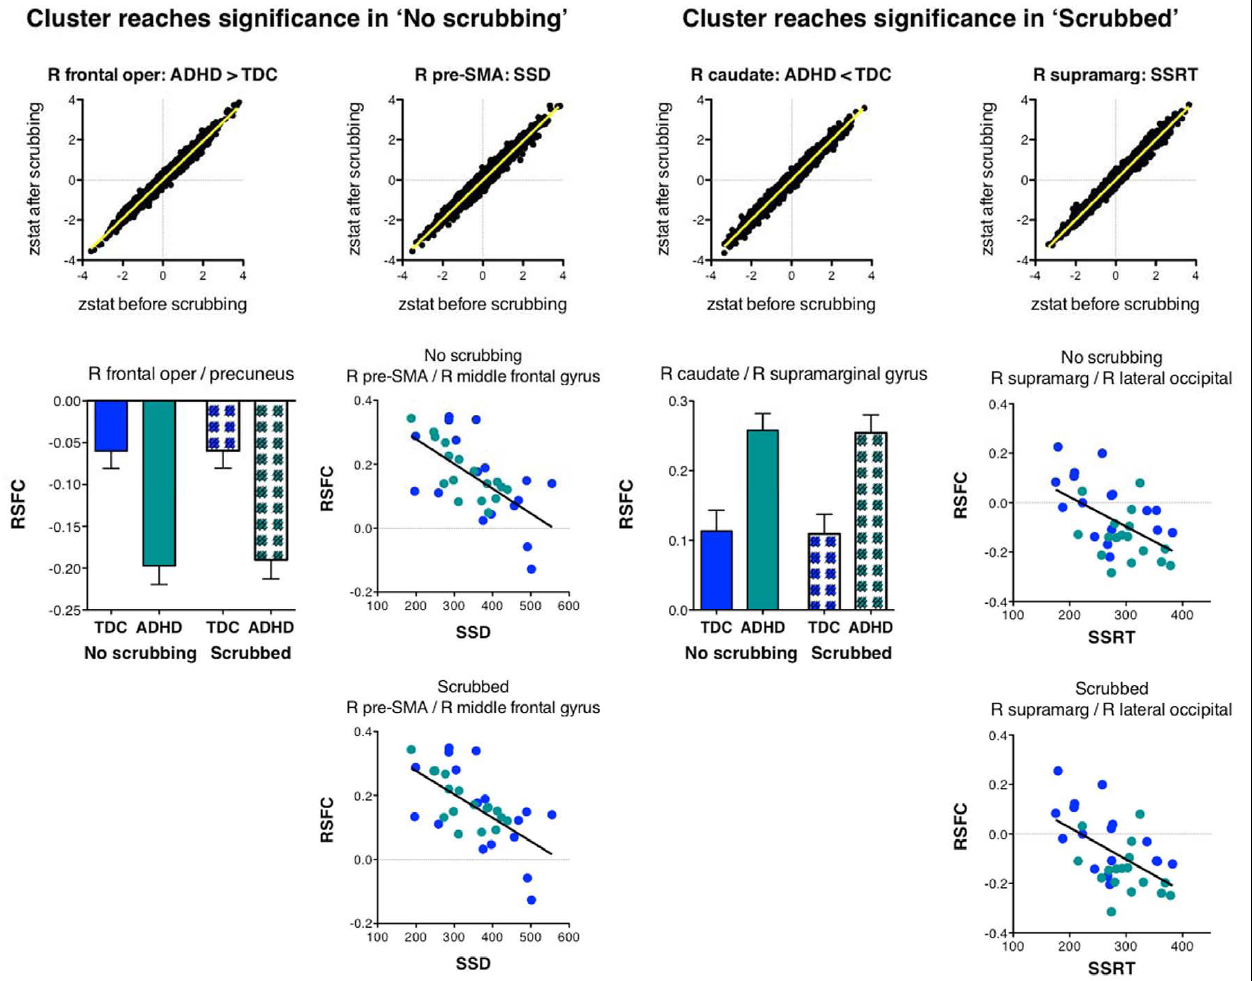
using the scrubbed data. In contrast, the two clusters on the right “appeared” in the analyses using the scrubbed data, but did not reach cluster significance in the analyses using unscrubbed data. For each cluster (column) the top row illustrates the similarity between the Z -statistic values of the effect of interest obtained for the analyses using unscrubbed and scrubbed